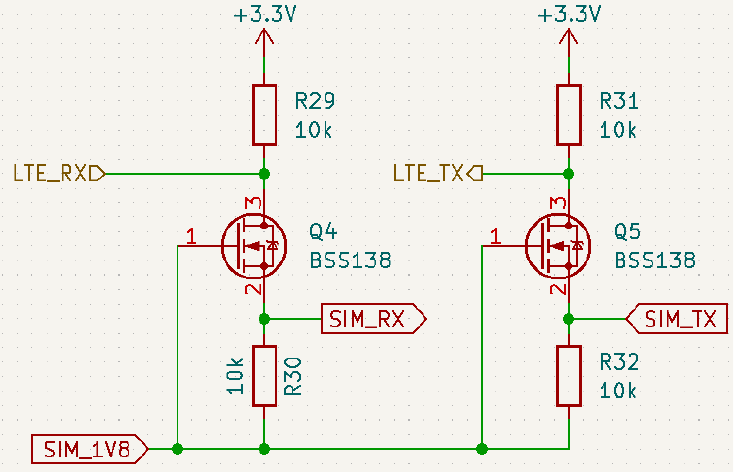
Figure 3. Voltage-matching circuit. The SIM_1V8 label refers to the 1.8 V voltage line that comes from the SIM7600E-H module.